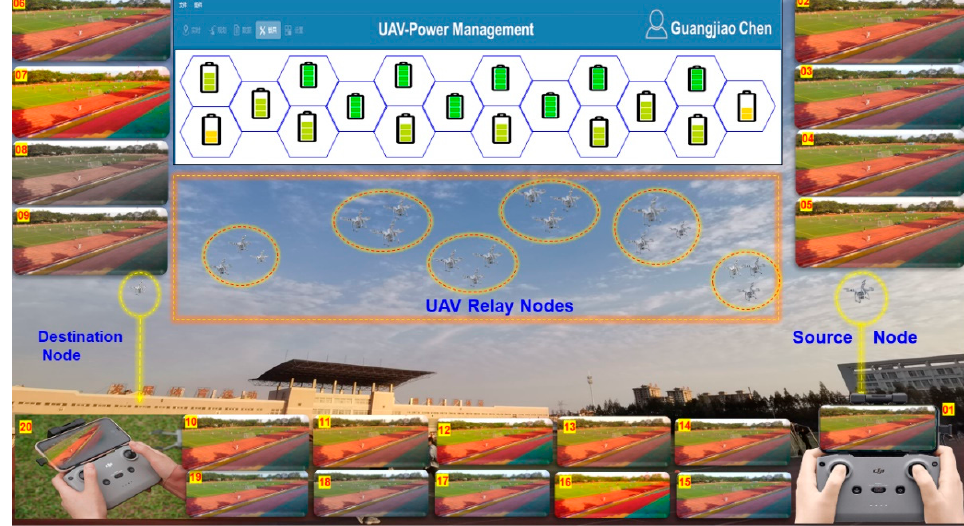
Figure 3. Cooperative communication retransmission experimental test.